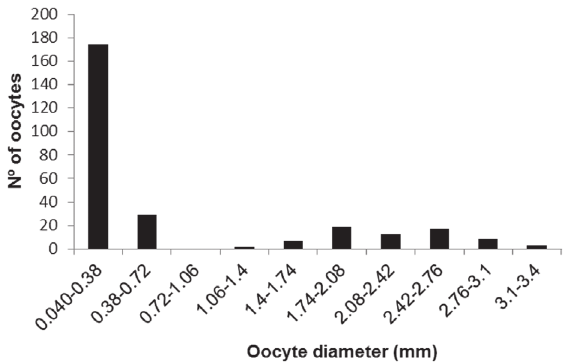
Figure 7 - Frequency of oocytes diameter classes (mm) in spawning capable ovaries of H. francisci